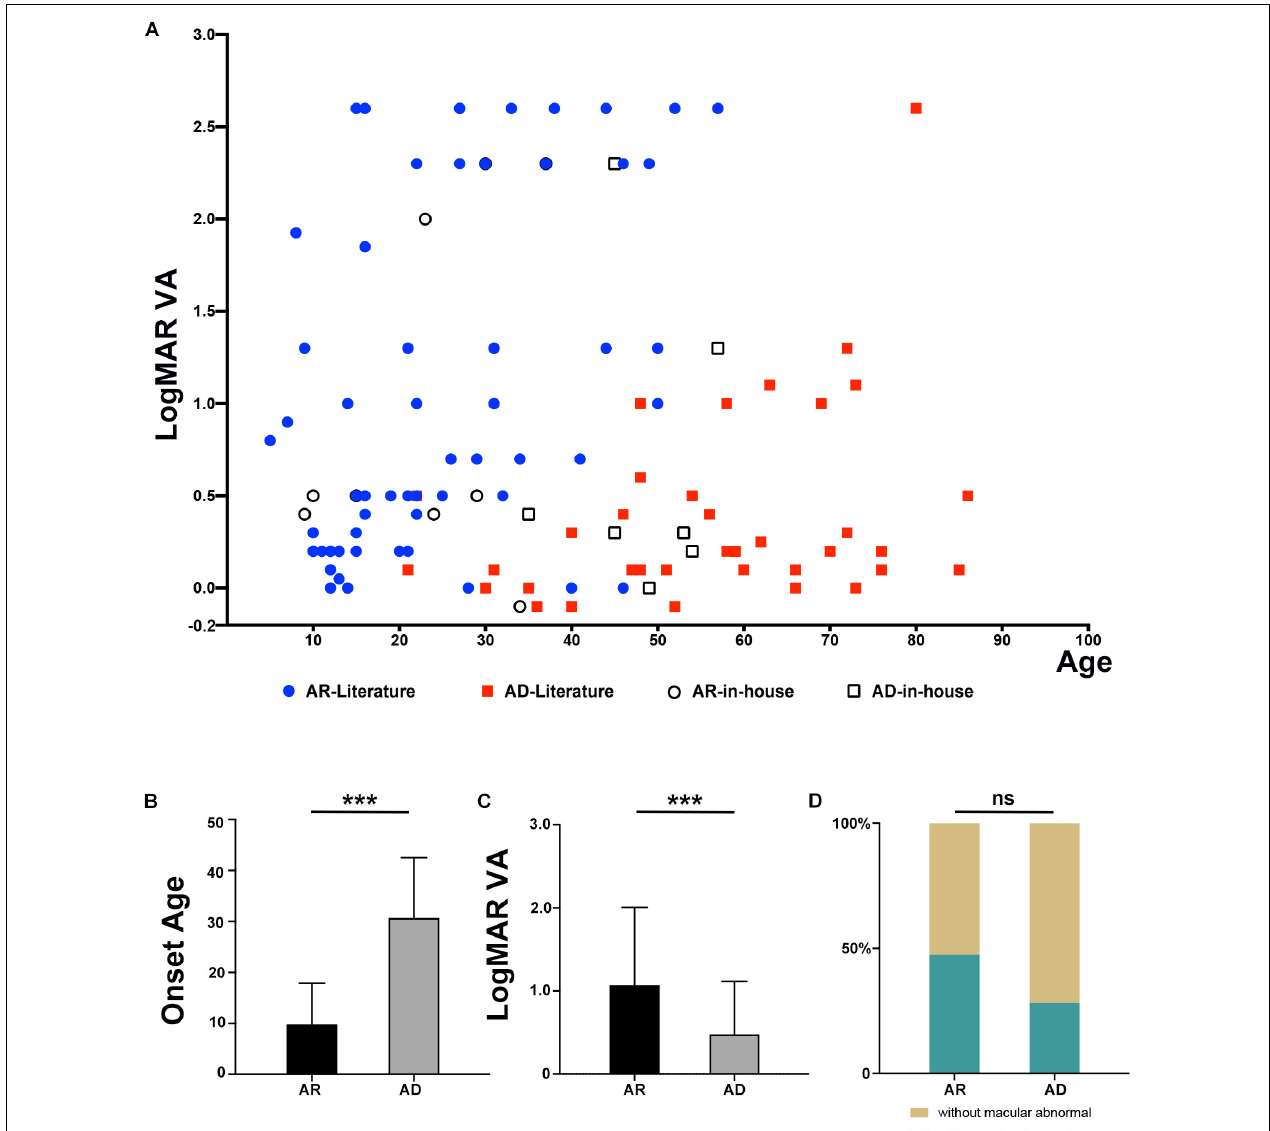
FIGURE 3 | Comparison of phenotypes in patients with an inheritance pattern for arRP and adRP. (A) Scatter plots of the LogMAR visual acuity of patients with AR and AD inheritance from our in-house data and the previously published literature. (B) Comparison of the onset ages of patients with AR and AD inheritance from our in-house data and the previously published literature. *** P = 2.76*10 − 11 . (C) Comparison of the LogMAR visual acuity of patients with AR and AD inheritance from our in-house data and the previously published literature. *** P = 1.75*10 − 4 . (D) Comparison of the macular abnormalities, including macular degeneration or macular atrophy, of patients with AR and AD inheritance from our in-house data and the previously published literature. ns mean not significant ( P =